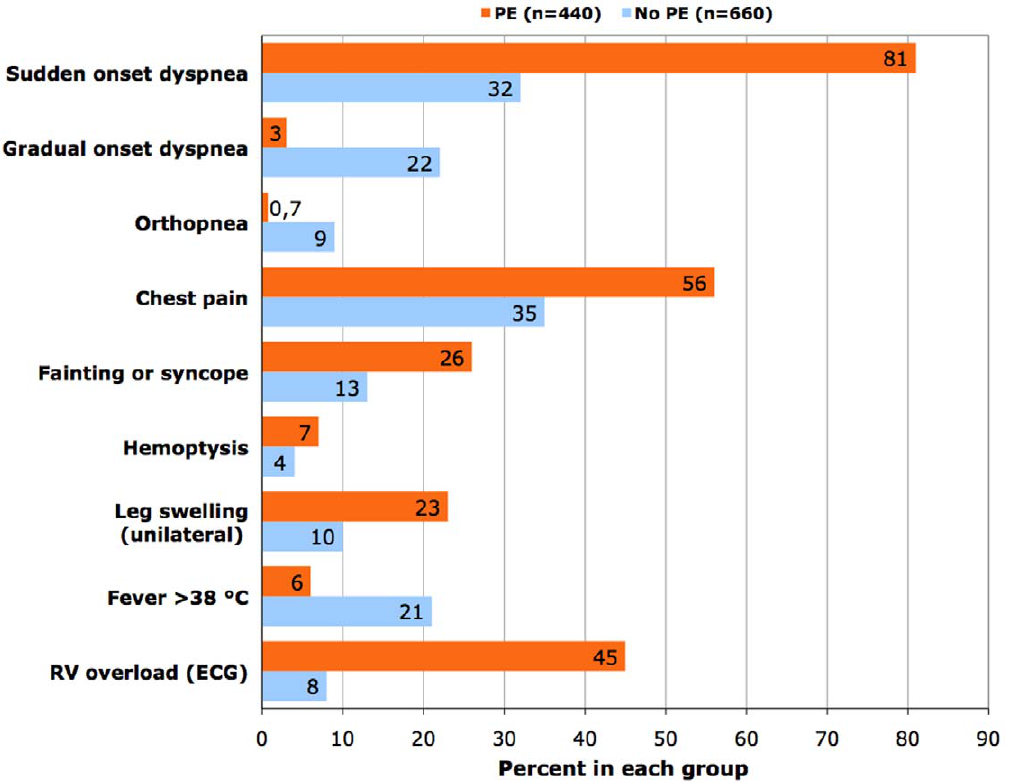
Figure 1. Prevalence of clinical symptoms and signs, and of electrocardiographic (ECG) signs of acute right ventricle (RV) overload in 1100 patients with suspected pulmonary embolism (PE). Data are from reference 5. P-values are , 0.001 for all the variables, with the exception of hemoptysis (p , 0.05).